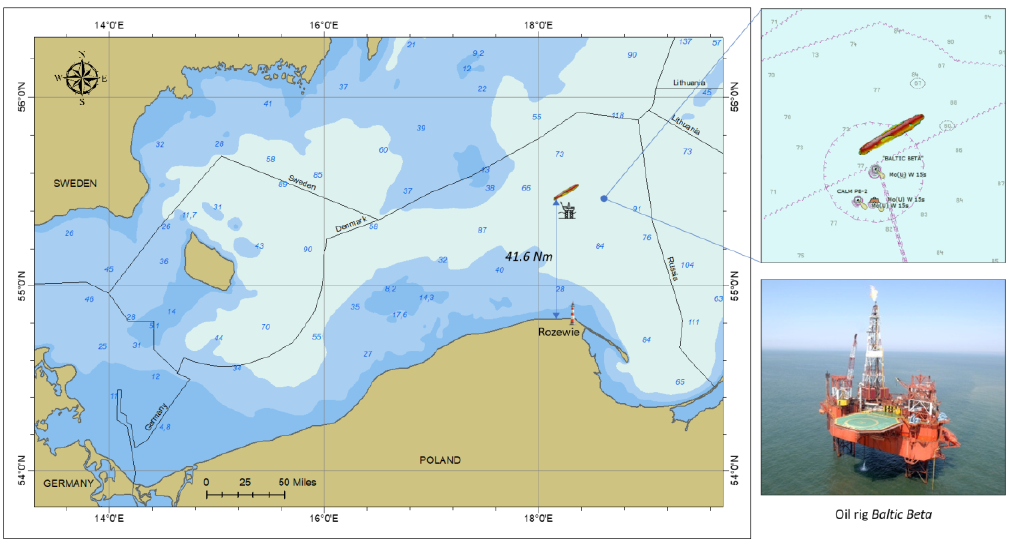
Figure 1. Detection location of the wreck of the German aircraft carrier Graf Zeppelin in the Baltic Sea.